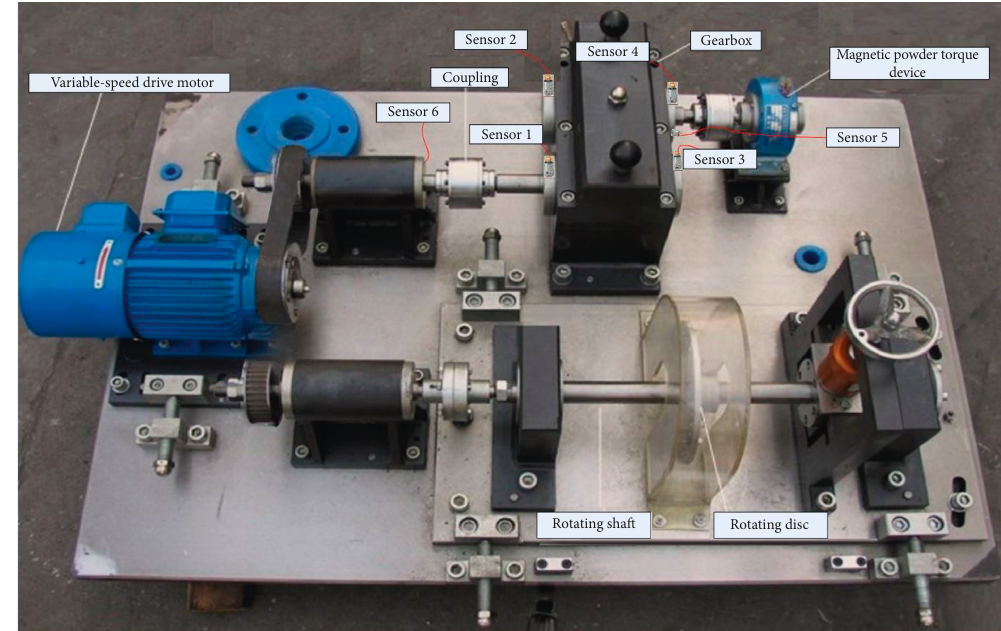
Figure 10: The test platform system.